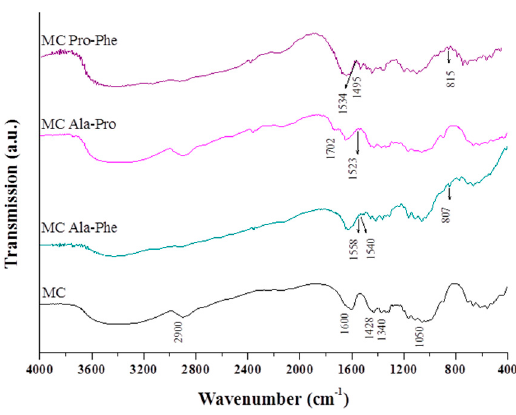
Figure 2. FTIR spectra of microcrystalline cellulose and microcrystalline cellulose loaded with amino acids.